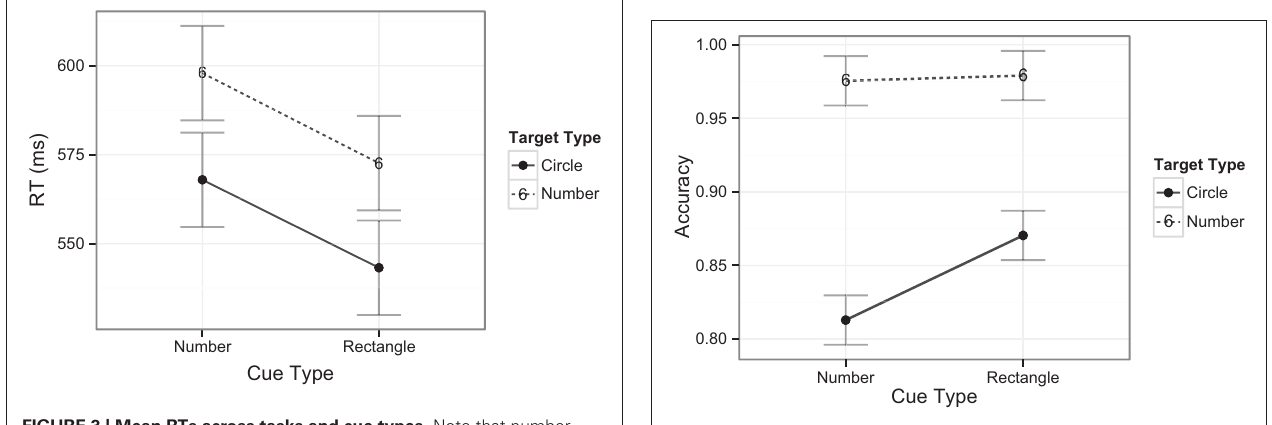
FIGURE 3 | Mean RTs across tasks and cue types. Note that number cues shared object properties with the number detection task, whereas rectangle cues did not share object properties with the task. Error bars indicate Fisher’s Least Significant Difference (FLSD) for the plotted effect.